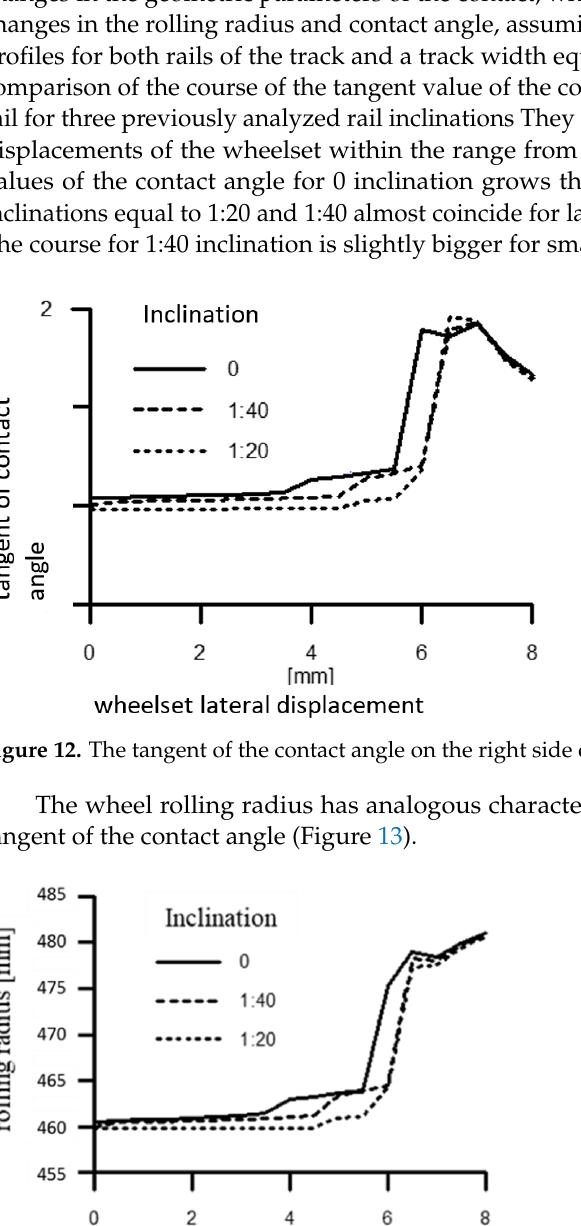
Figure 13. Temporary right wheel rolling radius for various rail inclinations.